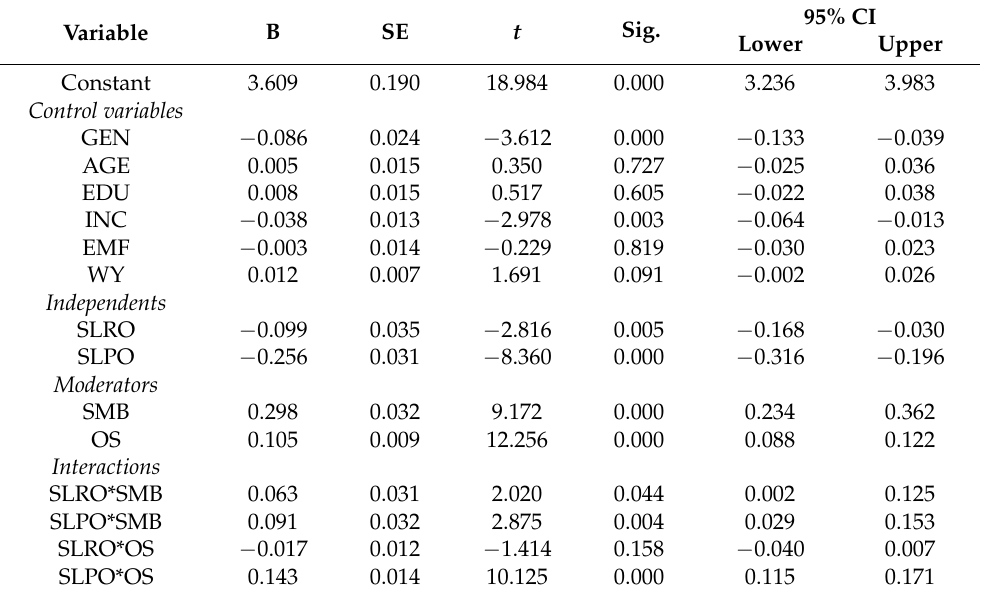
Table 3. Multiple and moderated regression results for the main effect and moderating effect ( N =